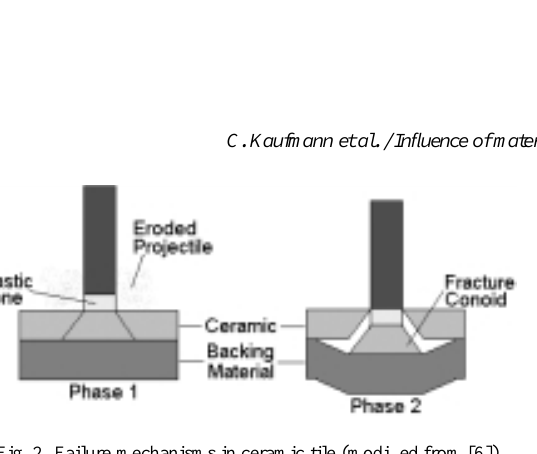
Fig. 2. Failure mechanisms in ceramic tile (modified from